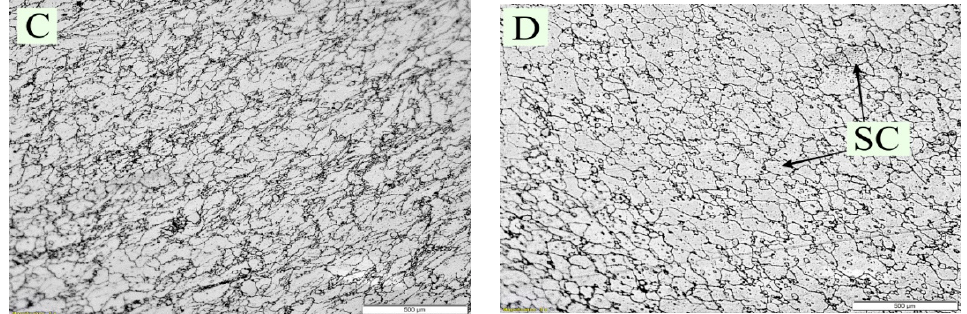
Figure 4. Microstructure of EN 52 steel from ( A ) non-DCT ( B ) DCT1 ( C ) DCT2 and ( D ) DCT3 samples (PC-primary carbides, SC-secondary carbides).